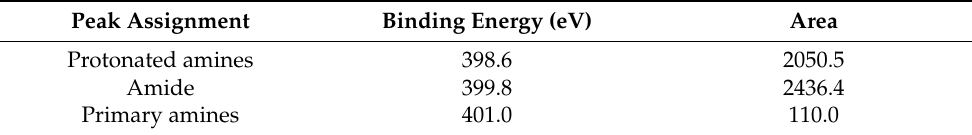
Table 4. Determination of the areas of the peaks in the XPS spectra of CBX-MG-PEI.